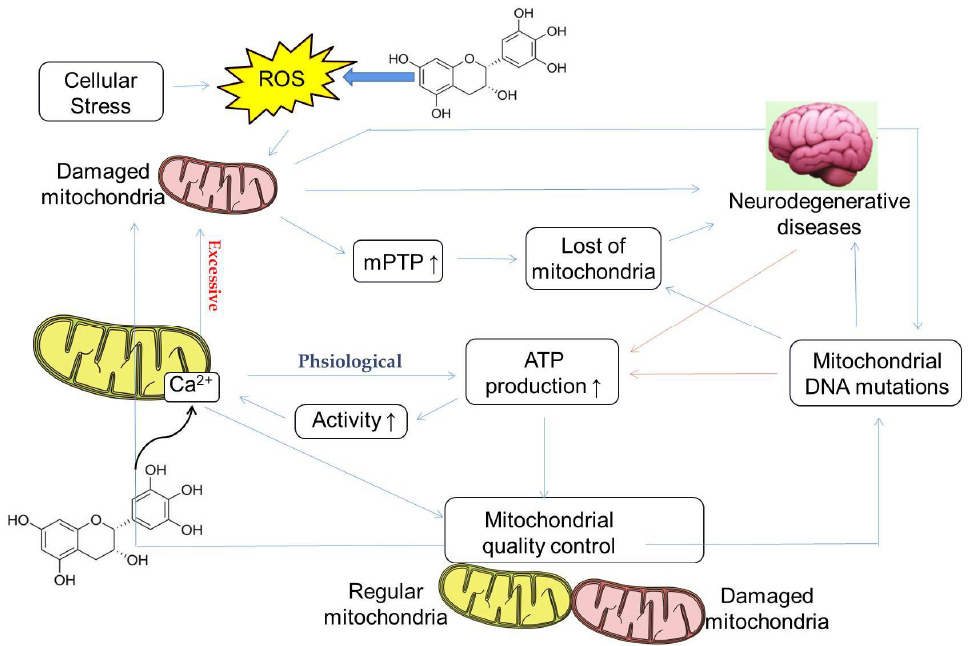
Figure 4. Possible mechanism of catechins regulating calcium homeostasis mitochondrial quality control involved in neurodegenerative diseases, reprinted/adapted with permission from Ref.